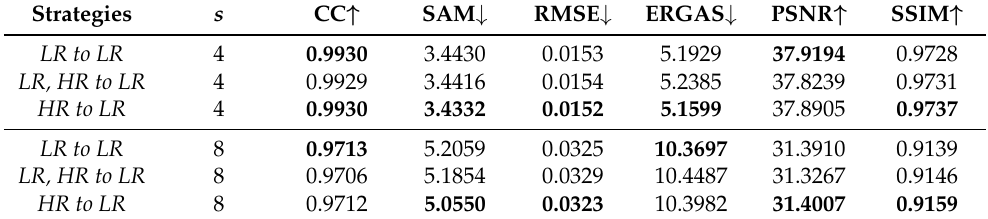
Table 4. Quantitative analysis of three Feedback strategies.